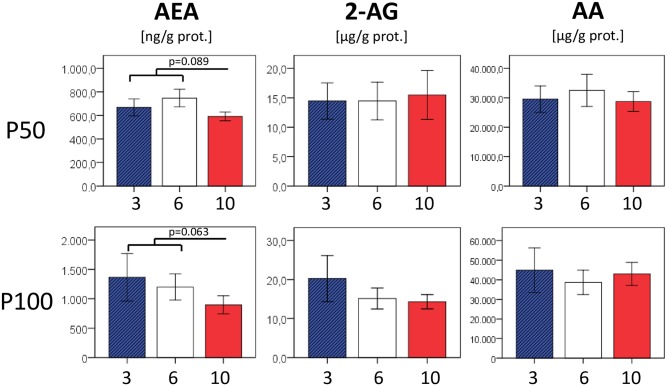
Concentrations of endocannabinoids anandamide (AEA) and 2-arachidonoyl glycerol (2 AG) as well as arachidonic acid (AA) in visceral (perigonadal) adipose tissue.Except for tendencies towards lower AEA concentrations in formerly underfed animals (P50: 10 vs. 3/6 p = 0.089; P100: 10 vs.3/6 p = 0.063) no differences between former nutrition groups were detected at P50 and P100, resp. n = 4–6 males per nutrition group.